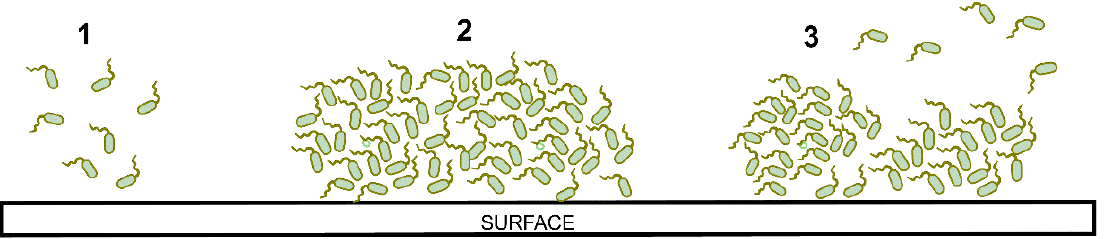
Figure 1. Representation of biofilm formation: ( 1 ) adhesion, ( 2 ) growing, ( 3 ) detachment.